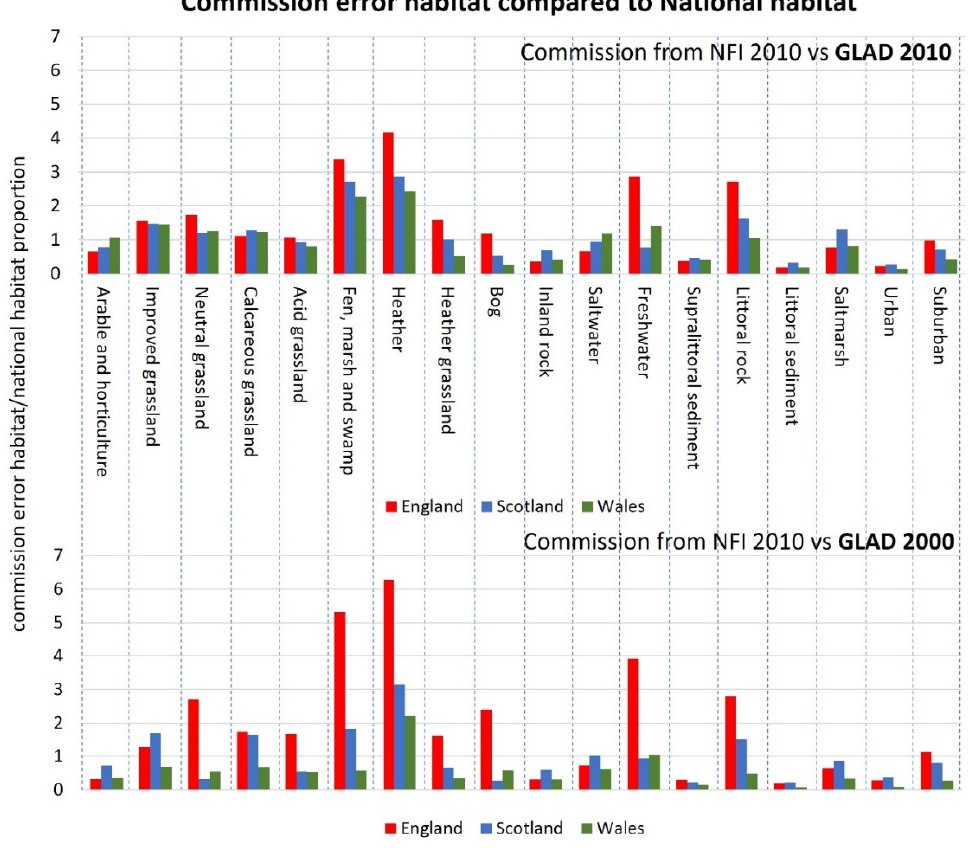
Figure 5. Difference between national habitat and commission error habitat GLAD FC 2010 and GLAD FC 2000 (positive numbers indicate commission error habitat proportion larger than national habitat proportion).